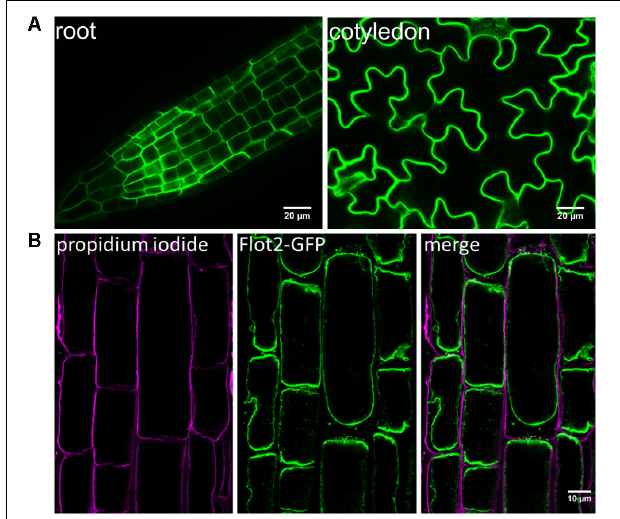
FIGURE 1 | Flot2-GFP localization at plasma membrane. (A) Confocal microscopy images showing Flot2-GFP localization at plasma membrane in epidermal cells of roots and cotyledons of Arabidopsis Flot2-GFP plants; (B) Confirmation of Flot2-GFP localization at plasma membrane in plasmolyzed root epidermal cells. The Flot2-GFP signal is detected at the plasma membrane of contracted protoplasts. Seedlings were treated with 0.8 M mannitol and subsequently stained with propidium iodide to mark cell